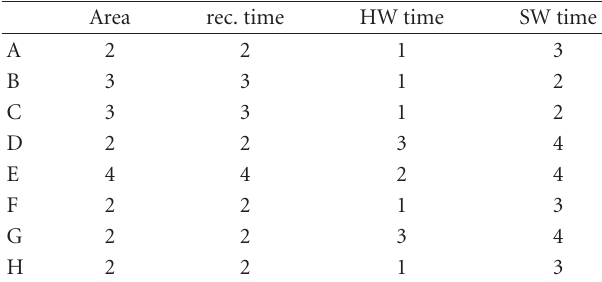
Table 1: Characteristics of tasks in Figure